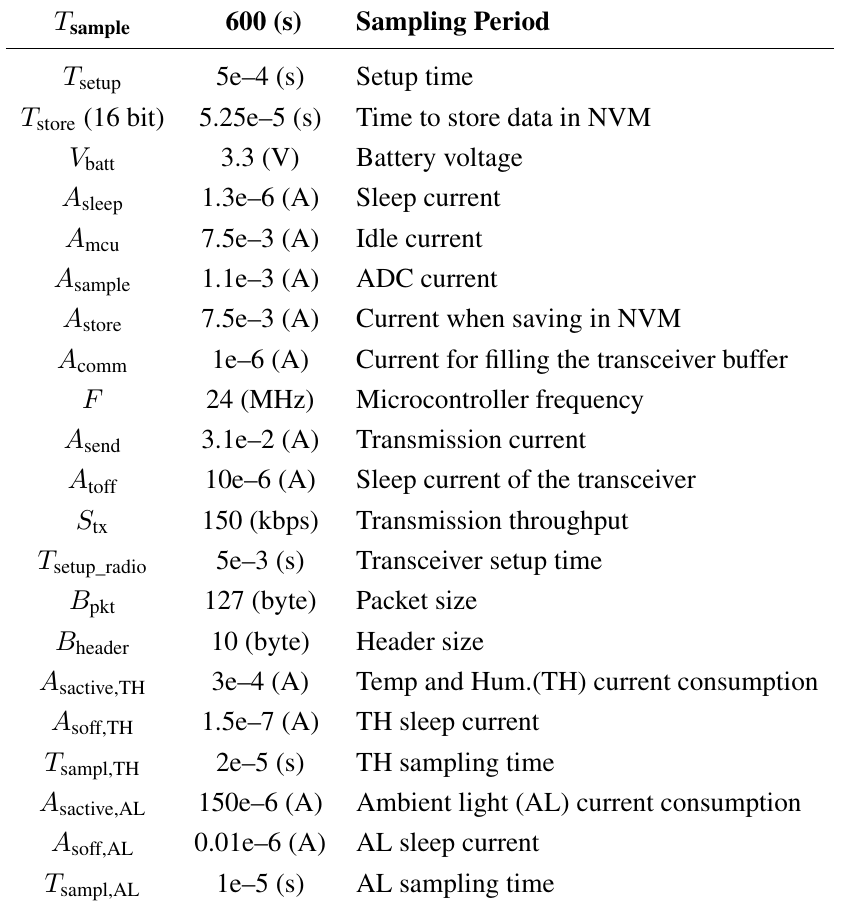
Table 1. Characteristics of the device taken as a reference in the power